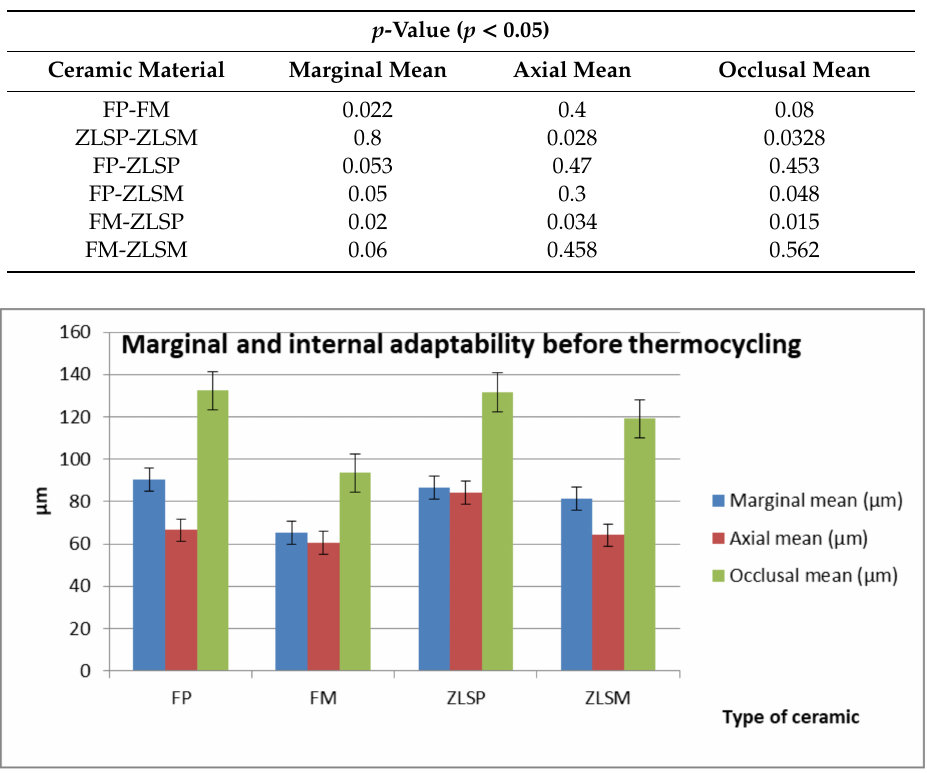
Table 5. Statistical results before cementing and thermocycling the samples.